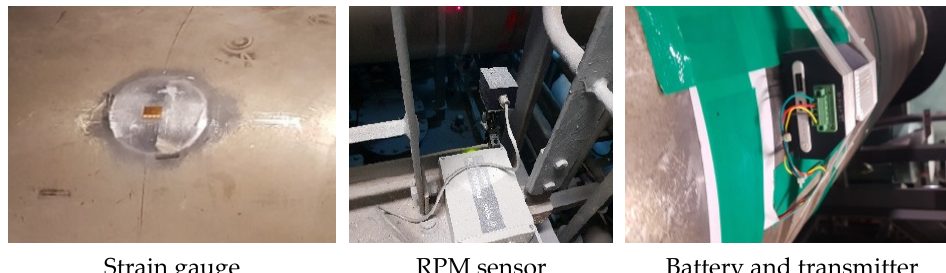
Figure 2. Installation for the strain gauge system.